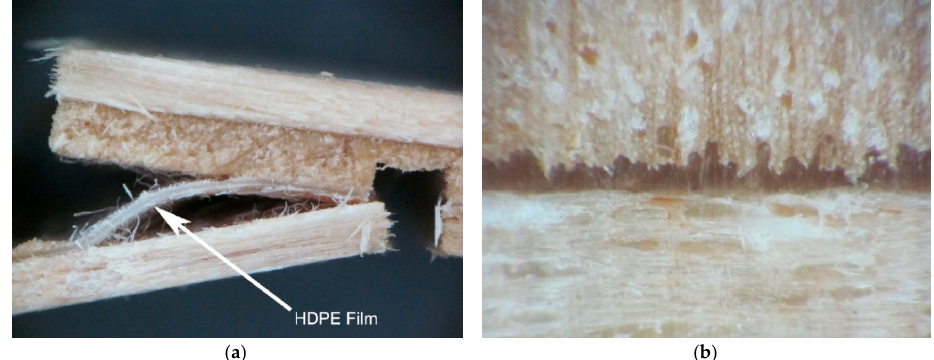
Figure 5. Micrograph of the HDPE-bonded plywood samples ( a ) prepared at 140 °C and 1 min after shear strength test; ( b ) prepared at 160 °C and 3 min.